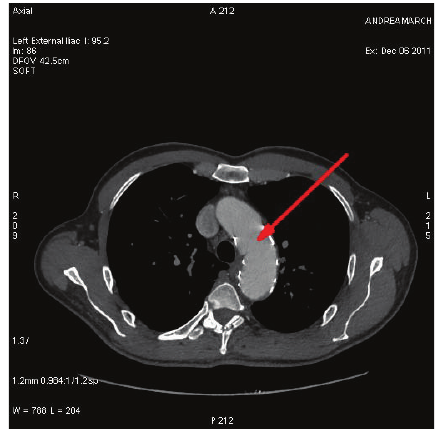
Figure 4: Six-month follow-up CTA shows the thoracic aorta without false lumen.